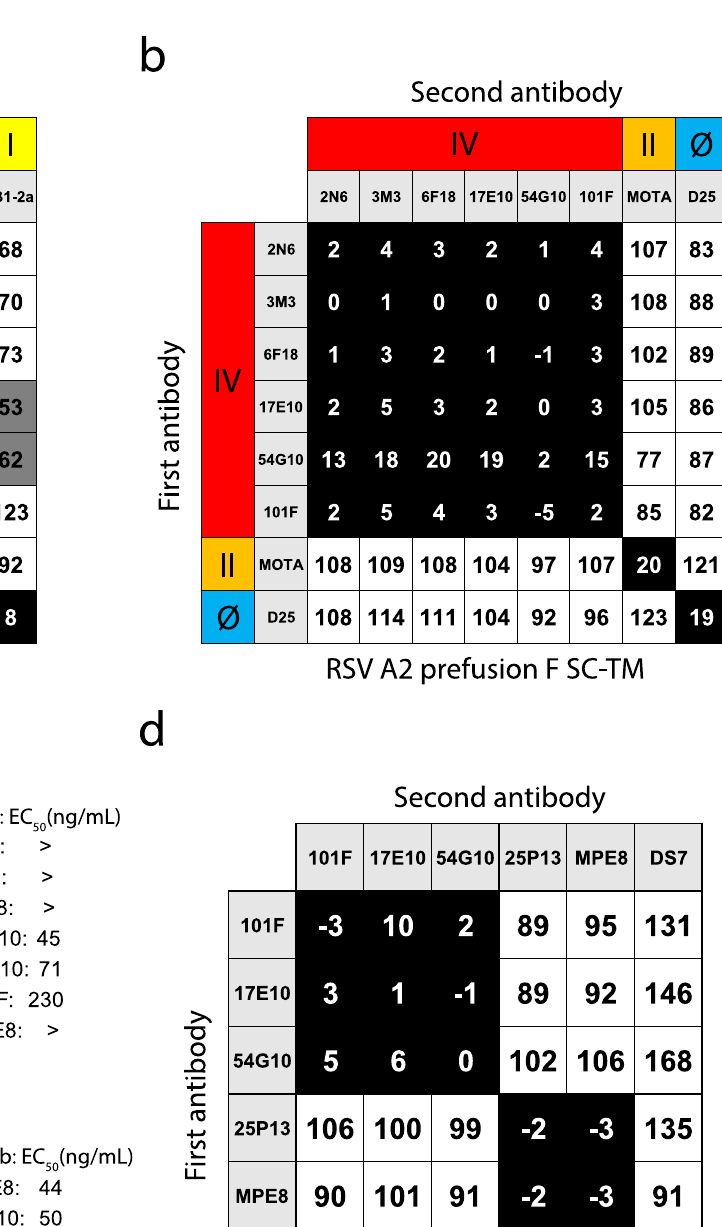
PLOS Pathogens| https://doi.org/10.1371/journal.ppat.1006837 February 22,